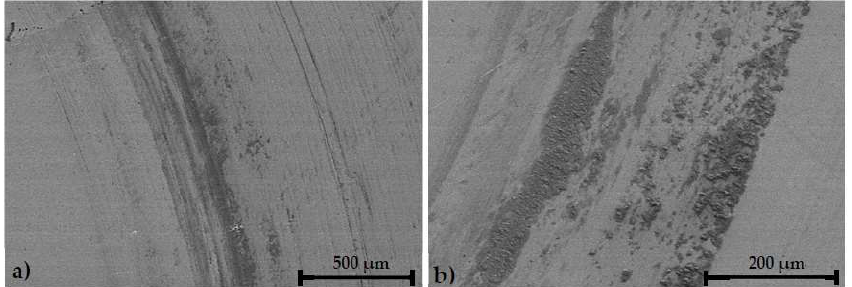
Figure 9. SEM micrographs obtained after the tribological test on the wear track of the M0 sample: ( a ) abrasion, and ( b ) adhesion wear mechanisms.